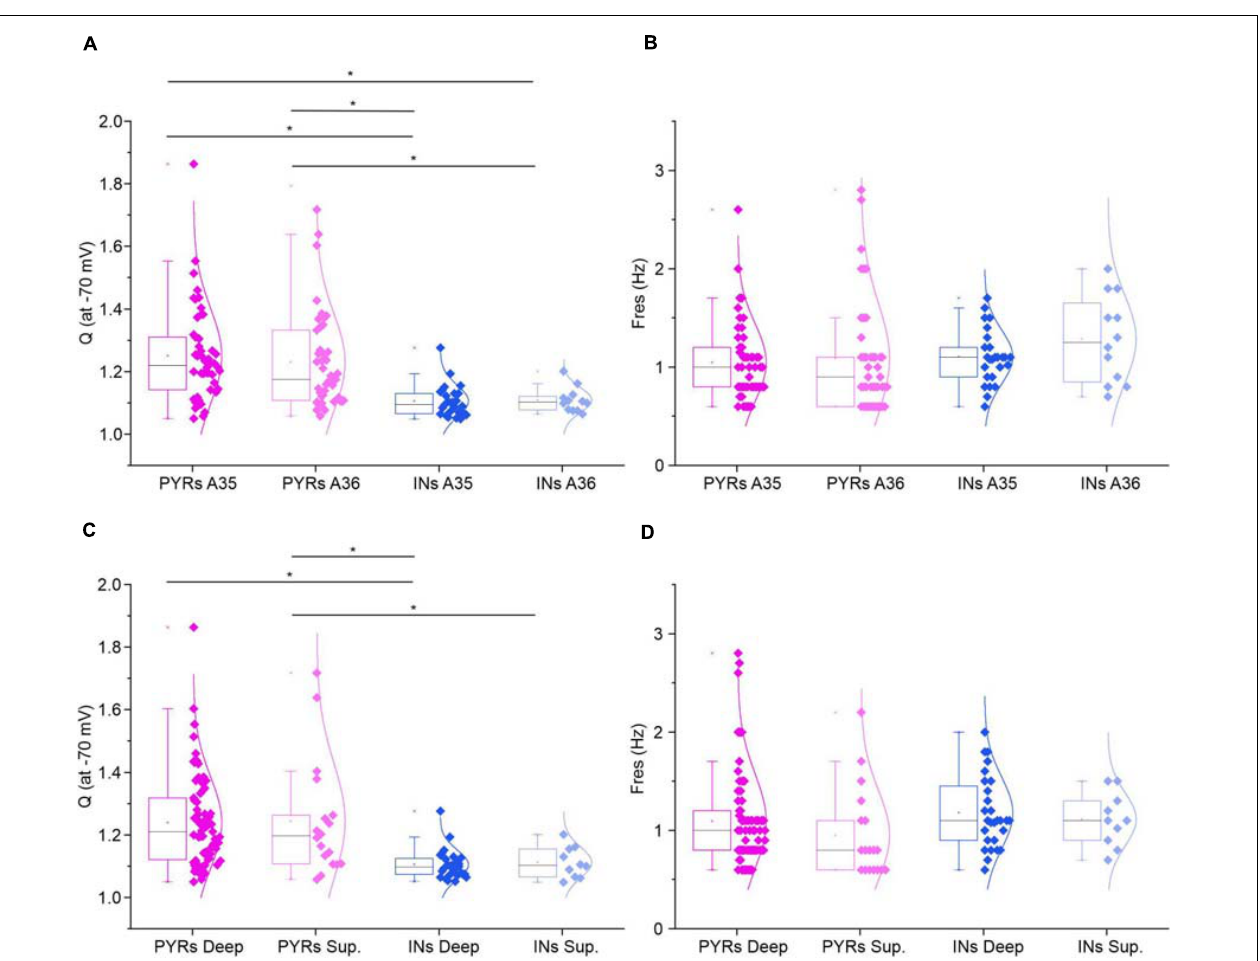
FIGURE 3 | Resonance in the different areas and layers of the PRC. (A,B) All-points half-violin plots flanked by summary box plots for Q (A) and F res (B) at –70 mV for resonant pyramidal neurons and GABAergic interneurons of Area35 vs. Area 36. (C,D) Same as (A–D) , for superficial vs. deep layers. Data were compared by One-Way ANOVA followed by Bonferroni post hoc . * p <